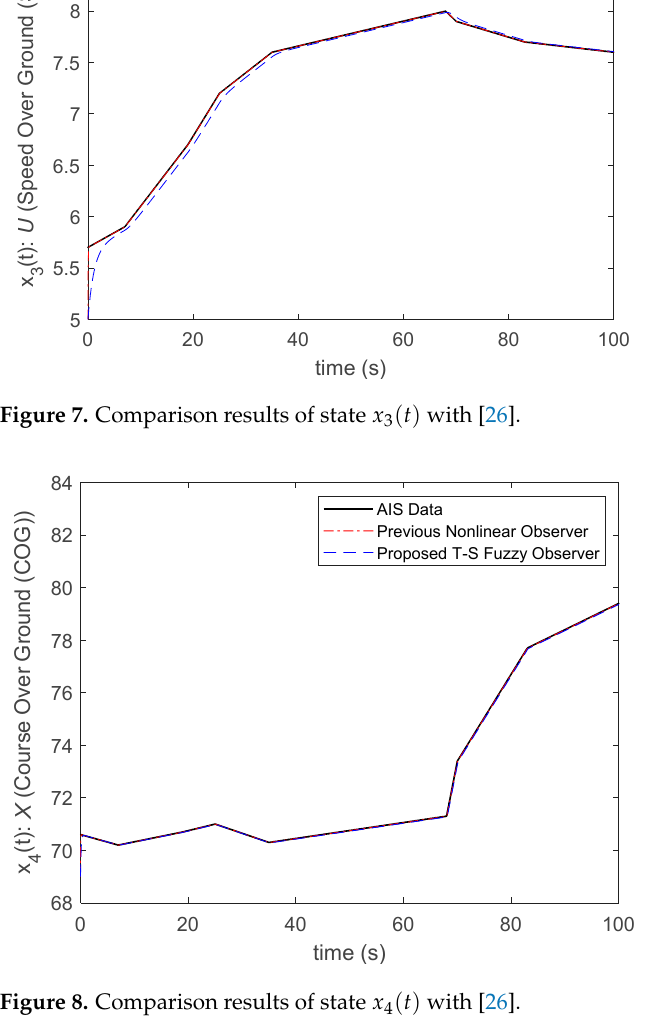
x t with [26]. x t with [26]. Figure 8. Comparison results of state x ( t ) with 4 4 4